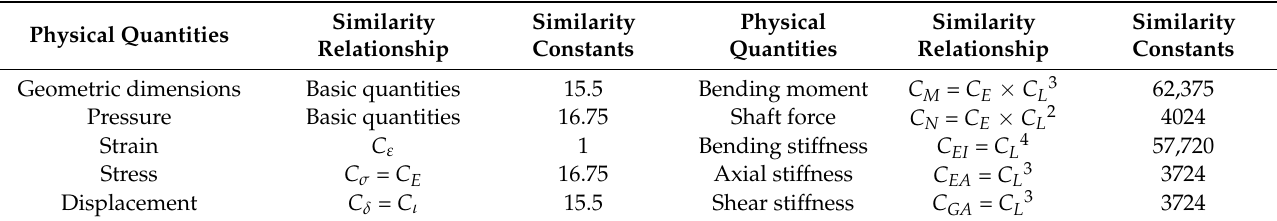
Table 3. Geometric parameters and material properties of the tunnel model.